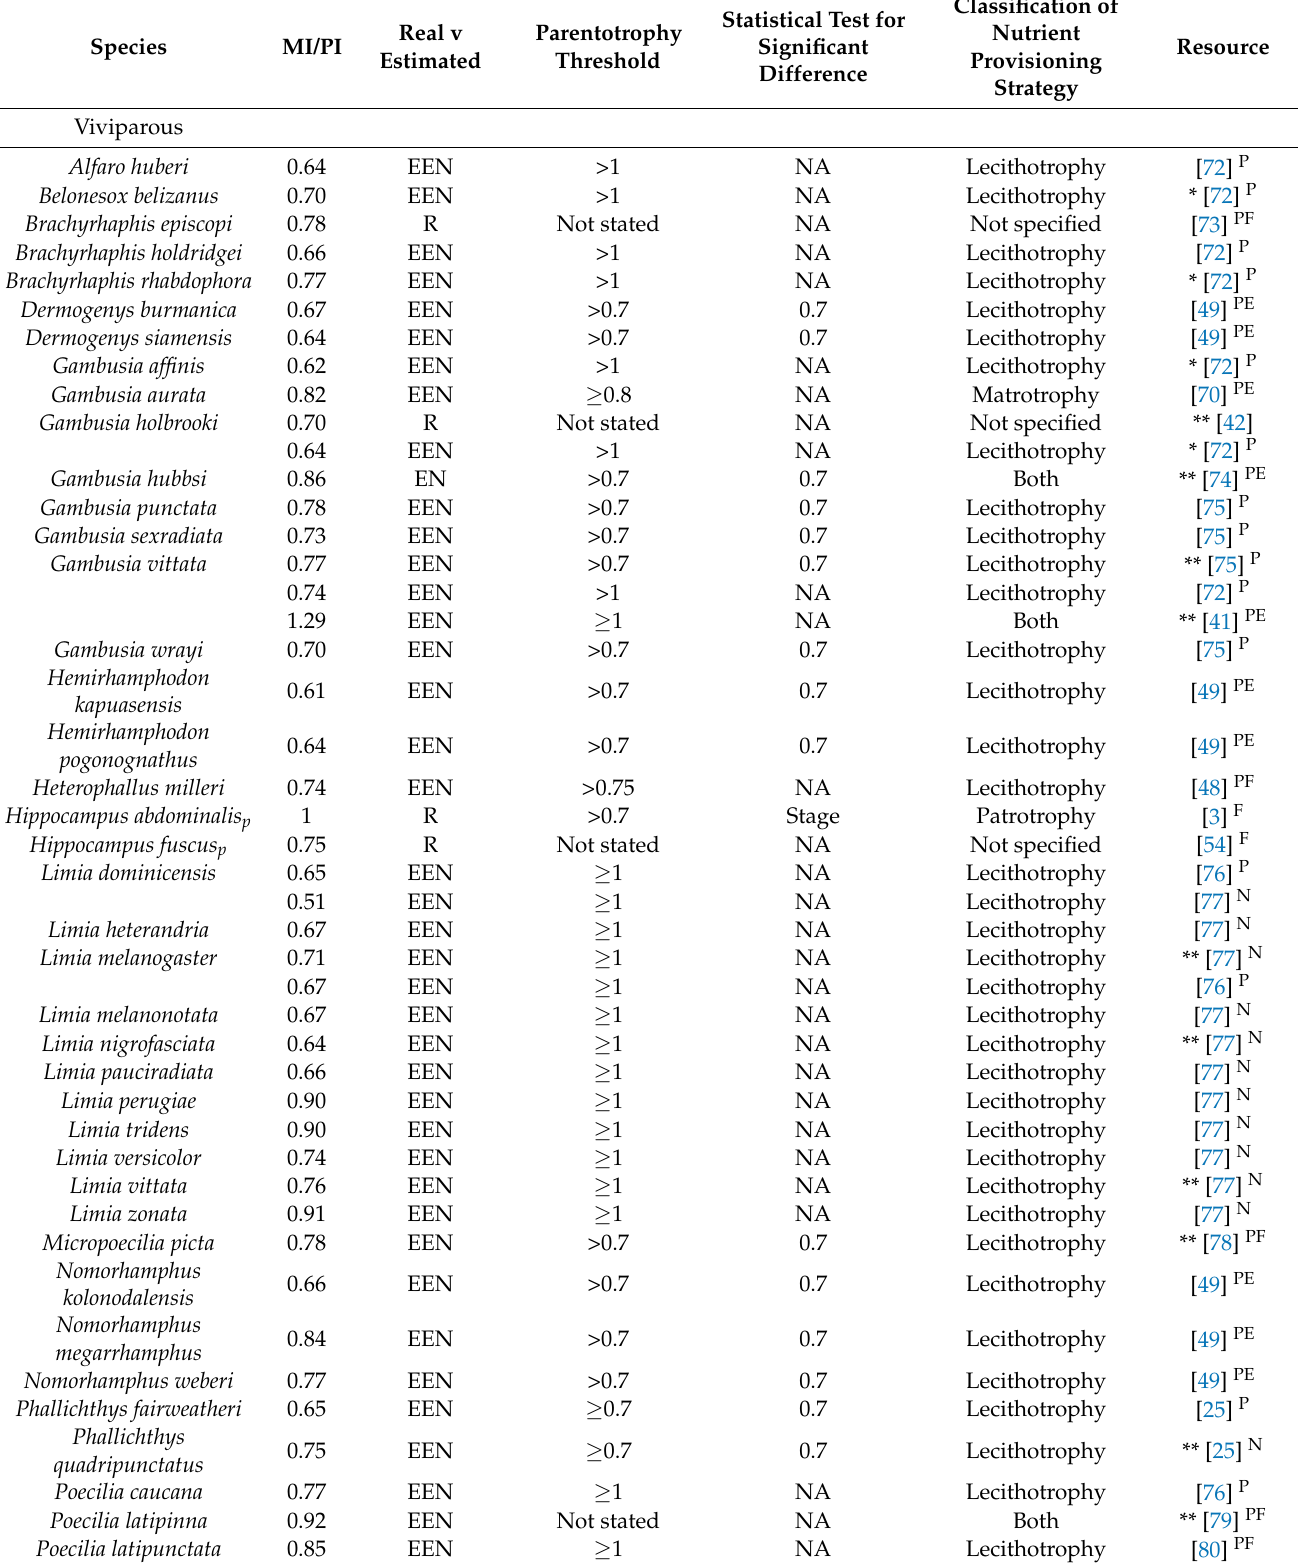
Table 1. Parentotrophy indices calculated for teleost fishes indicate discrepant application of a threshold value for